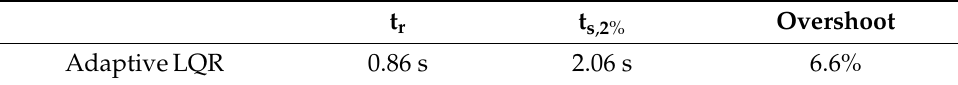
Figure 11. Euler angles ( top ), inertial velocities ( bottom left ) and altitude change ( bottom right ) in altitude change using LQR. Table 8. Results of height control with the adaptive version of LQR.